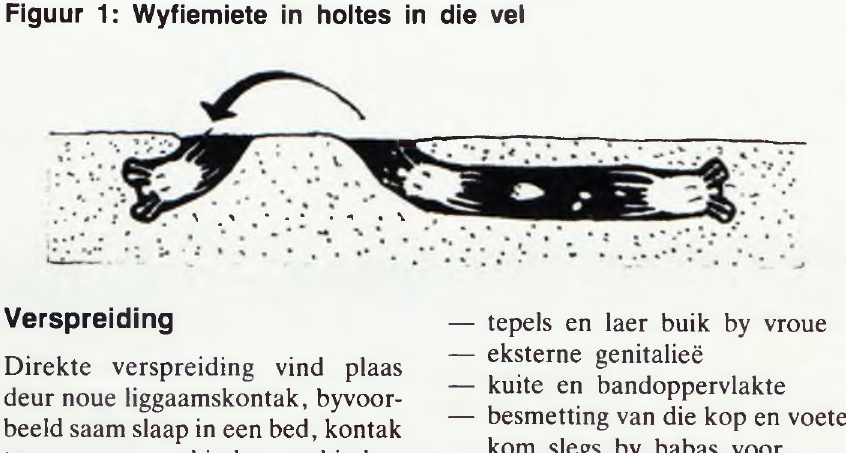
Figuur 1: Wyfiemiete in holtes in die